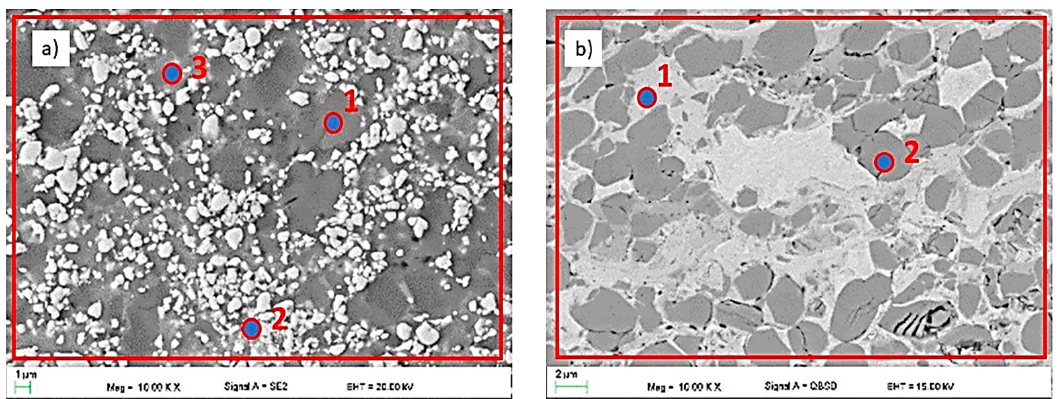
Figure 5. The microstructure of the ( a ) WC and ( b ) CrC coatings.